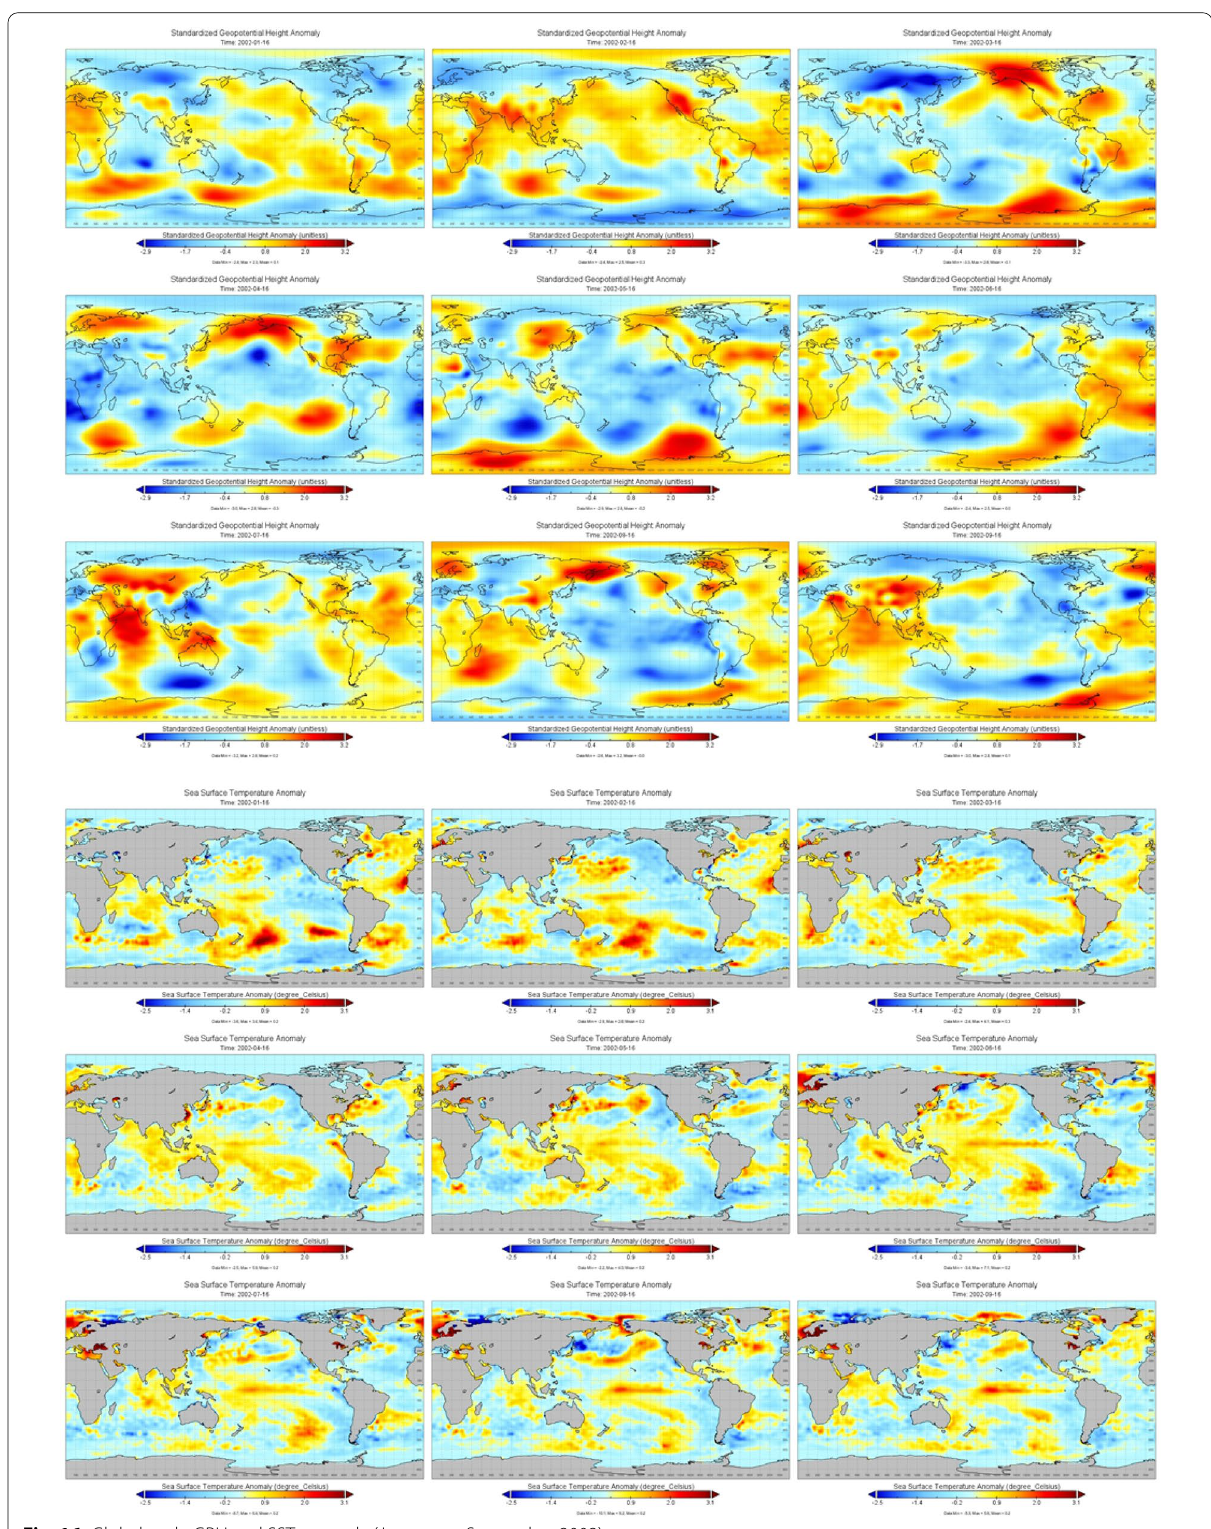
Fig. 16 Global-scale GPH and SST anomaly (January to September